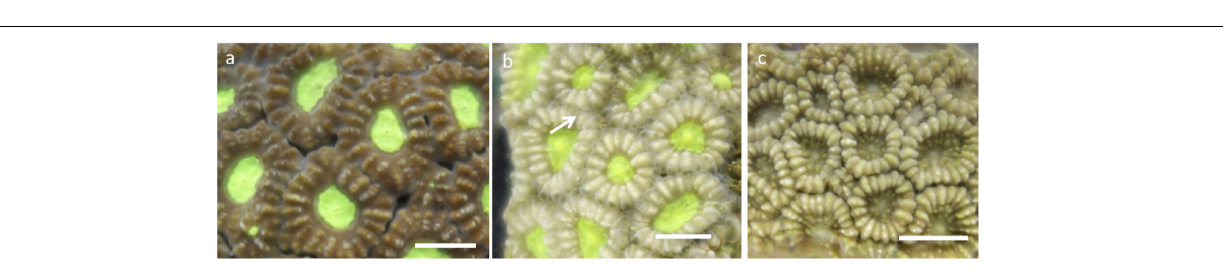
FIGURE 2 | Survival of favites colemani explants: (a) alive: Unbleached with coral tissue, (b) alive: Bleached with coral tissue (c) dead: Bleached and necrosed (no coral tissue, skeleton exposed). Scale = 0.5